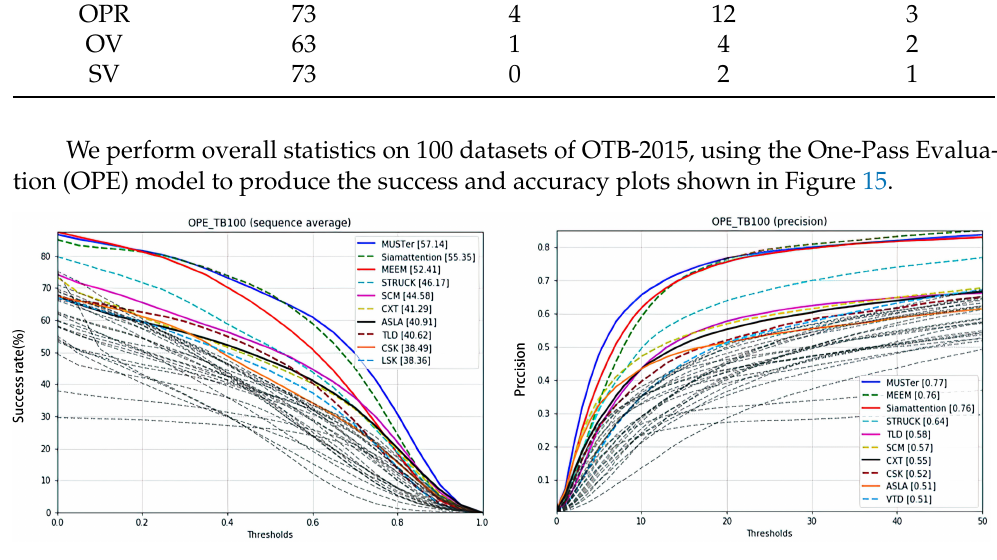
Figure 15. Success plot and precision plot of OTB100. The proposed tracker is shown in the success plot by the green dotted line, ranking second. Its average success rate is 55.35, 2.94% higher than MEEM and 1.71% lower than MUSTer. It is shown in the precision plot with a red solid line, ranking second, parallel with MEEM. The average accuracy is 0.76, 12% higher than STRUCK and 0.01% lower than